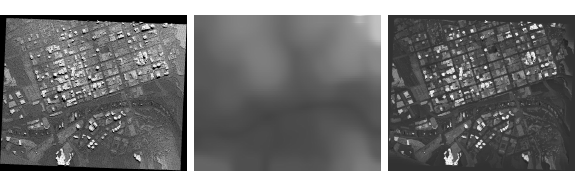
Figure 10. Section from the Pl´eiades Melbourne scene, right: filled height-map, both 2500 m × 2000 m Fig. 10 shows also the filled an corrected height-map on the right side. Fig. 11 shows the georeferenced DSM, DTM and nDEM from the height-map.